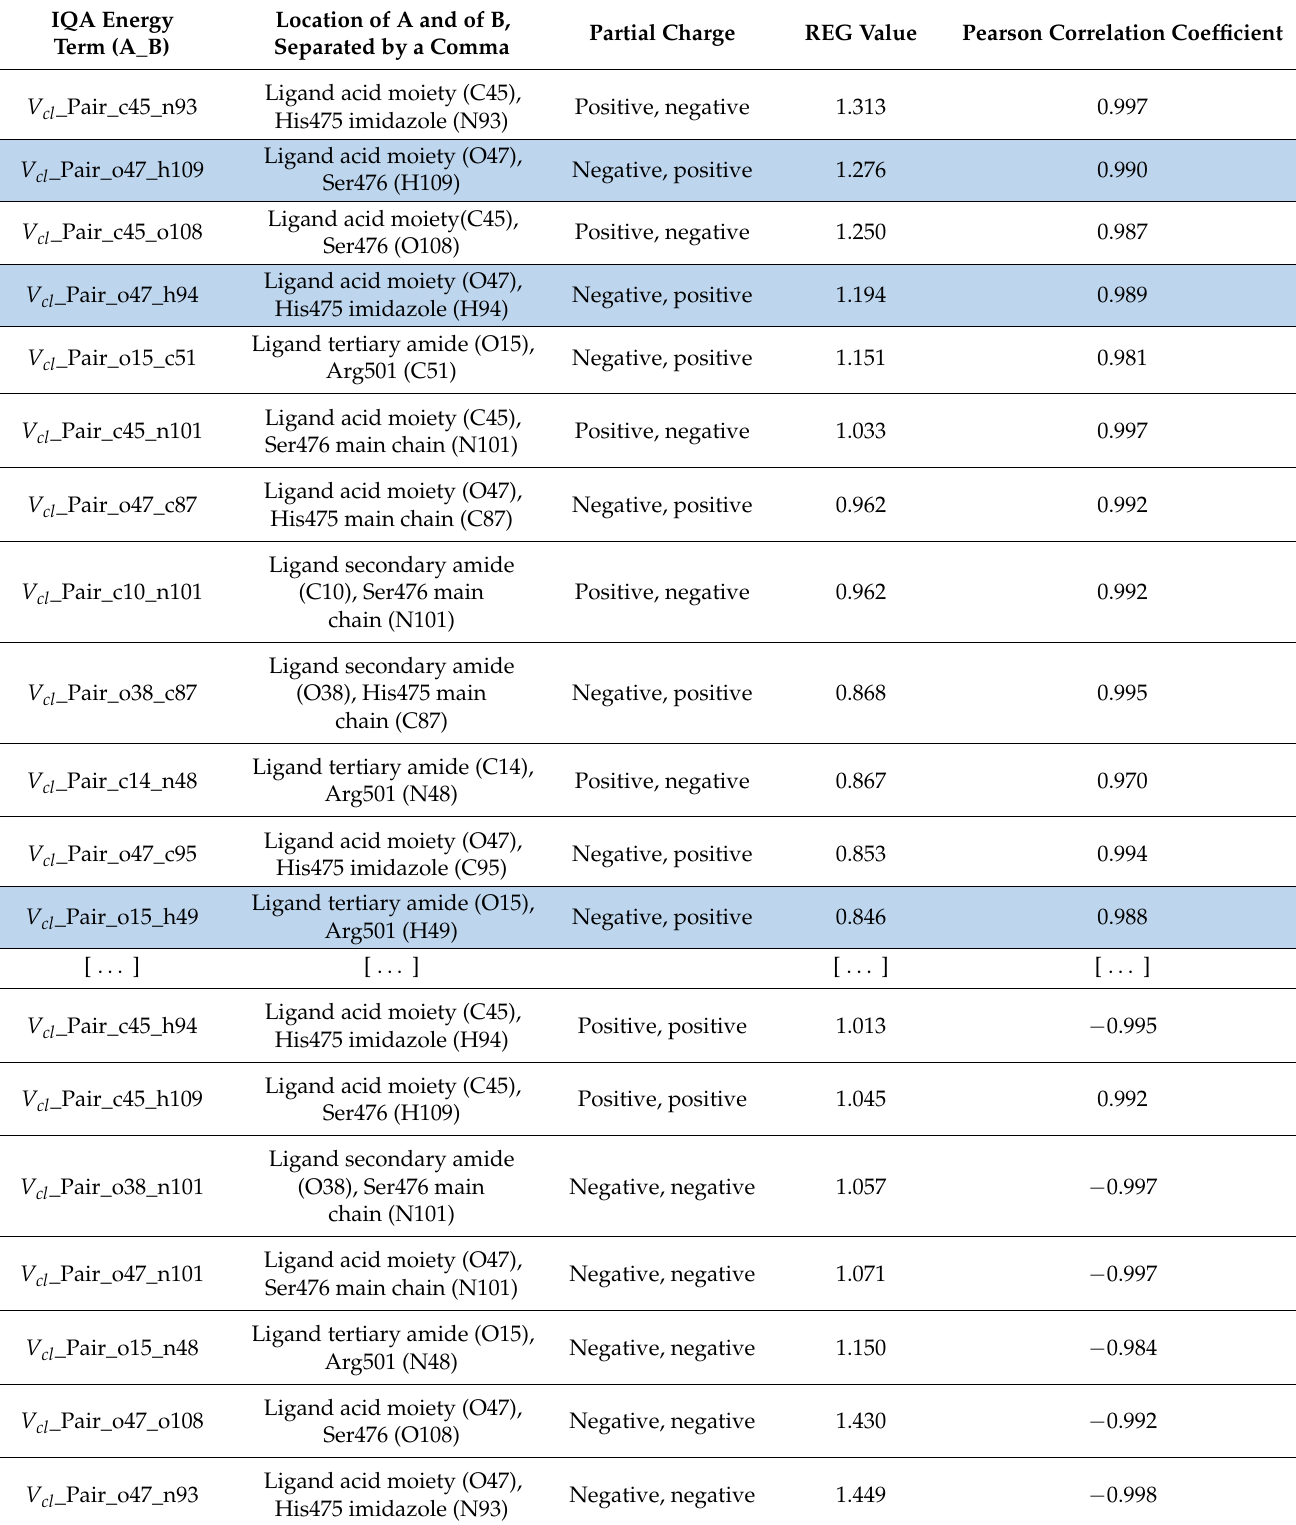
Table 5. The top pairwise interactions ( A-B ranking) for segment 2 of 3CJ4, in favour of the sys- tem’s behaviour (top part) and against the system’s behaviour (bottom part). The highlighted rows represent the pairwise interaction between hydrogen acceptors and the hydrogen atom in hydrogen